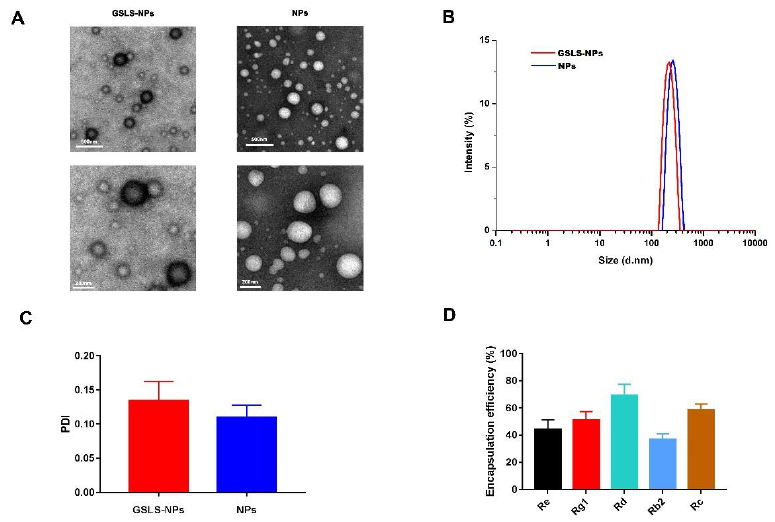
Figure 1. Characterization of nanoparticles. ( A ) Transmission electron microscopy images of GSLS- NPs and empty NPs. Low magnification, scale bar = 500 nm. High magnification, scale bar = 200 nm. ( B ) Particle Size. ( C ) PDI value. ( D ) Encapsulation efficiency.